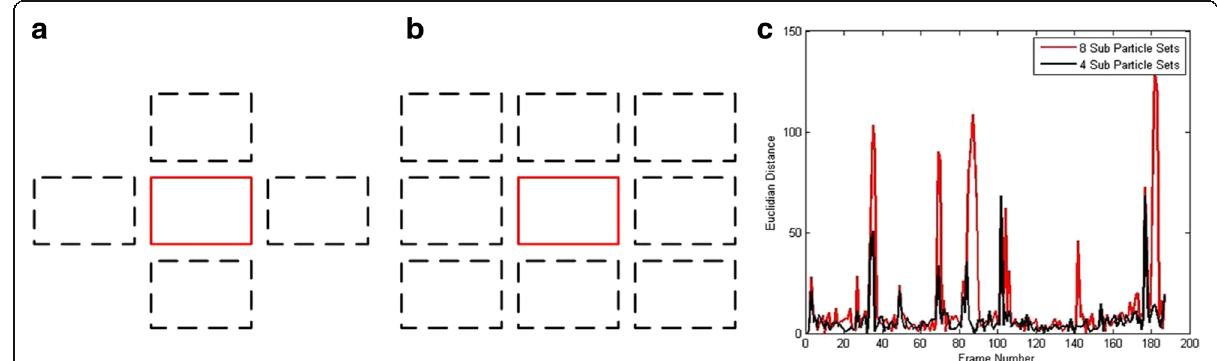
Fig. 5 a Four sub particle sets, b eight particle sets, and c Euclidian distance of “ basketball_2 ” using eight sub-particle sets and four sub-particle